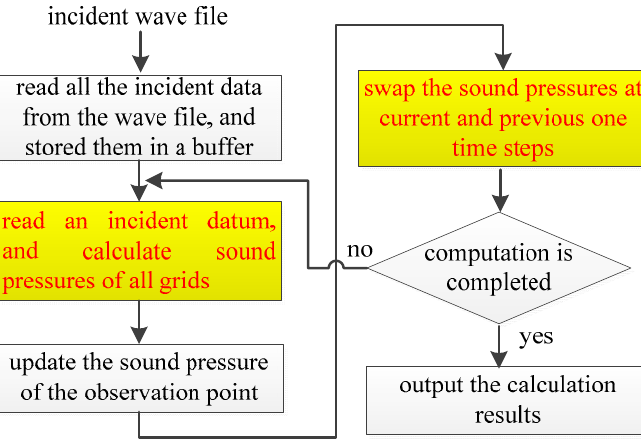
Figure 7. Computation flow of the software simulation.